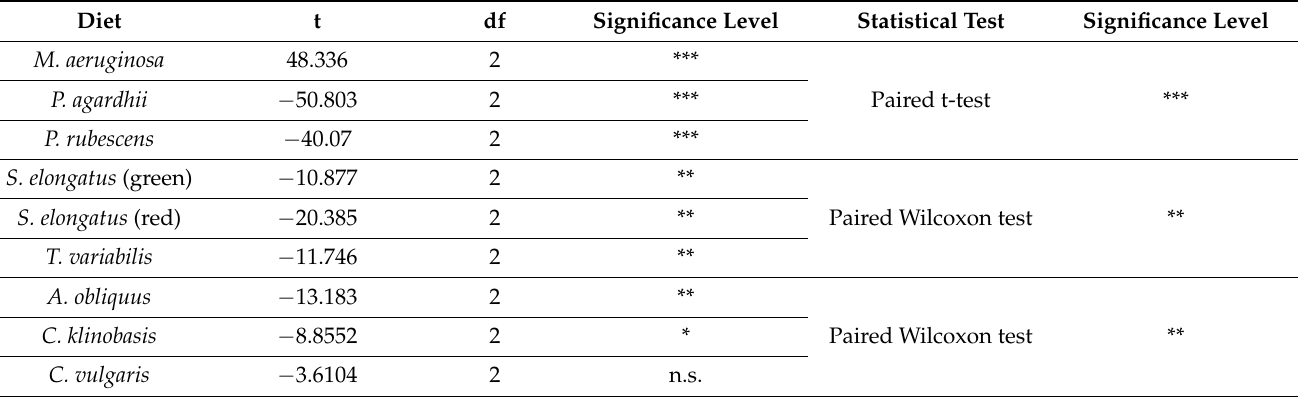
Table 3. A comparison of the δ 13 C values for the diet and D. magna at the end of the experimental